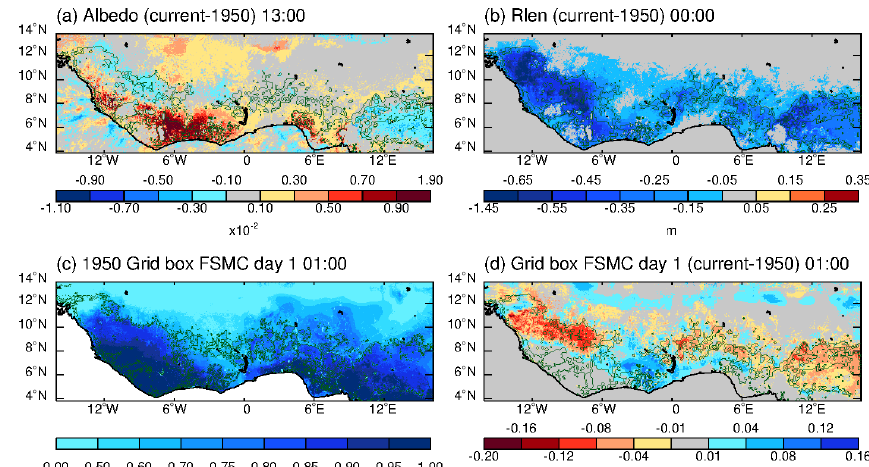
Figure 3. (a) Changes in albedo, (b) changes in roughness length, (c) 1950s initial FSMC, and (d) changes in initial FSMC. Green contours show where there has been deforestation in (a) , (b) , and (d) and the 1950s forested region in (c) . Small changes either side of zero are shown in